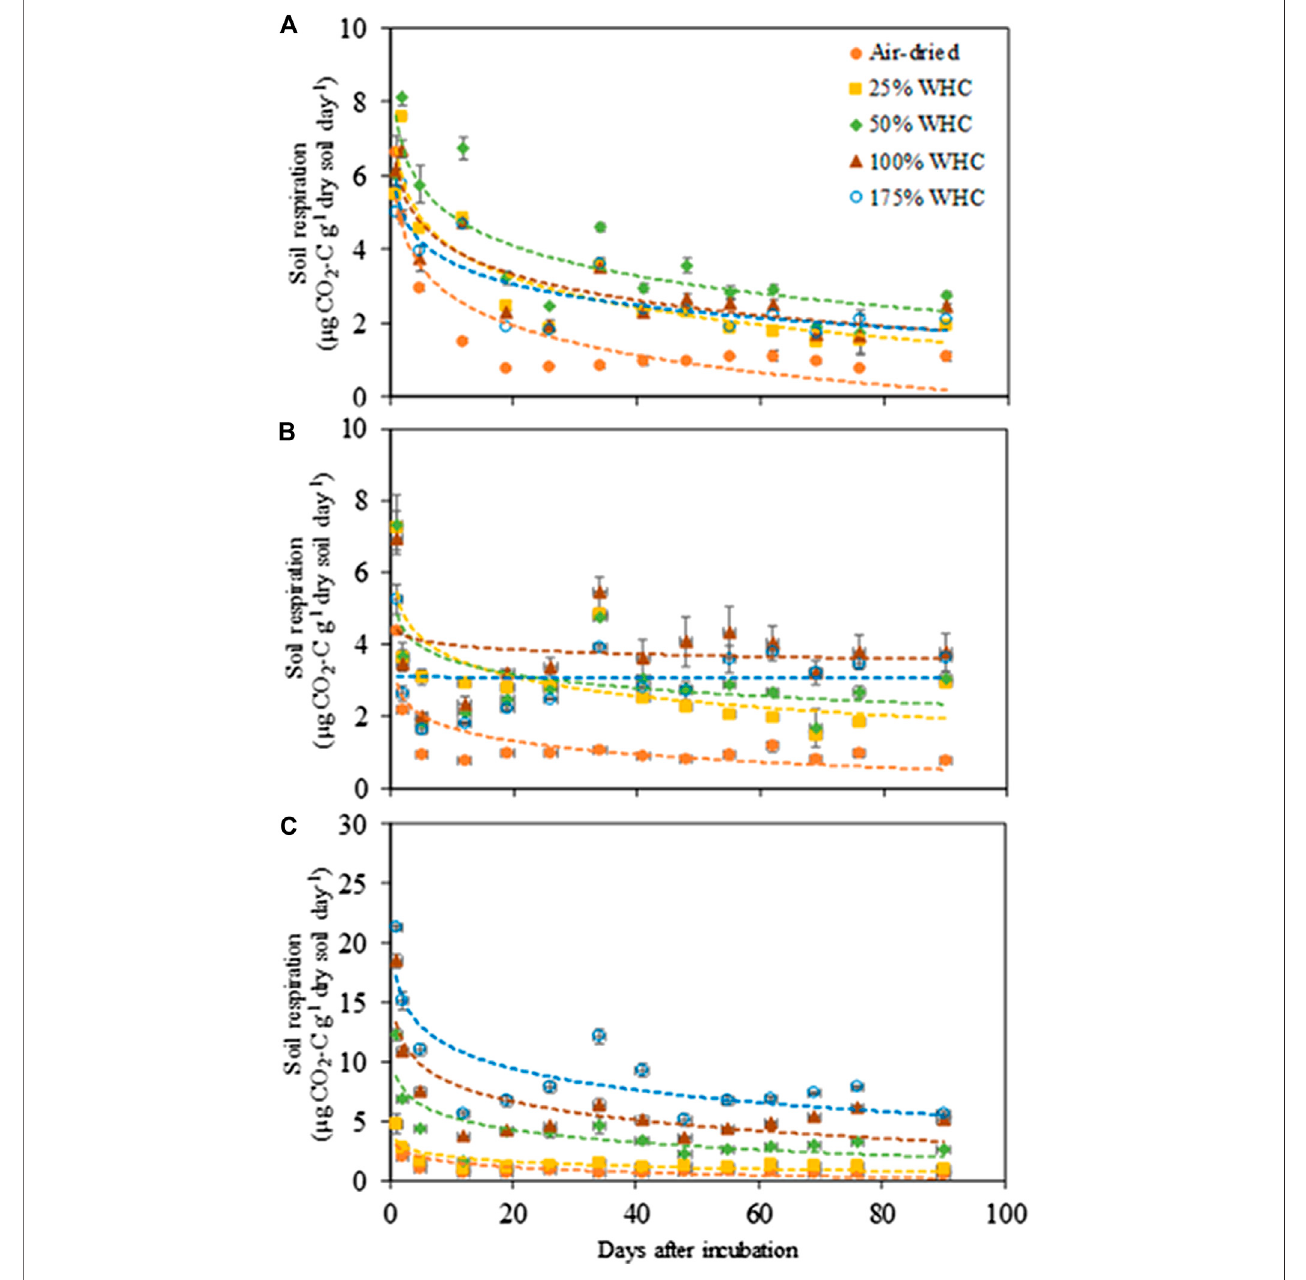
FIGURE1| Microbialrespirationrateinresponsetosoilmoisturelevelsin (A) Ultisol, (B) Al fi sol,and (C) Vertisolsoils.Errorbarsrepresentstandarderror( n (cid:1) 3).The regression functions are logarithmic for all soil moisture treatments in all soil types. Note the y axis scale is 3 × larger for clay soils.